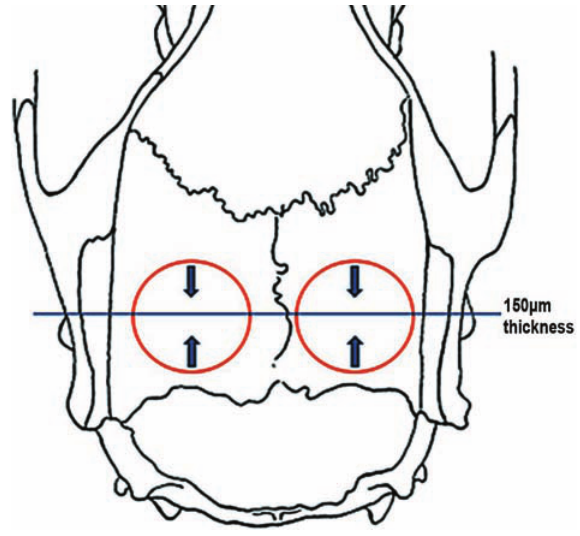
Figure 4- Preparation of the 150-µm-thick sections. The arrows indicate the wear direction to the center of the